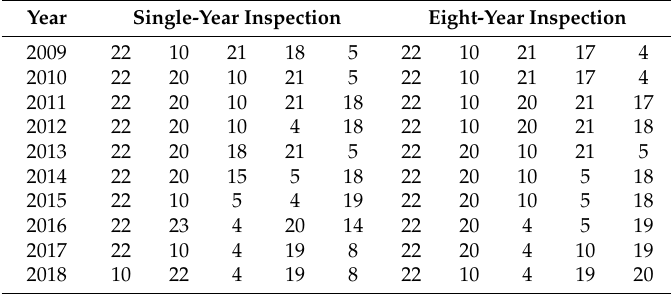
Table 3. List of explanatory variables for superstructure since 2009 using LASSO with and without